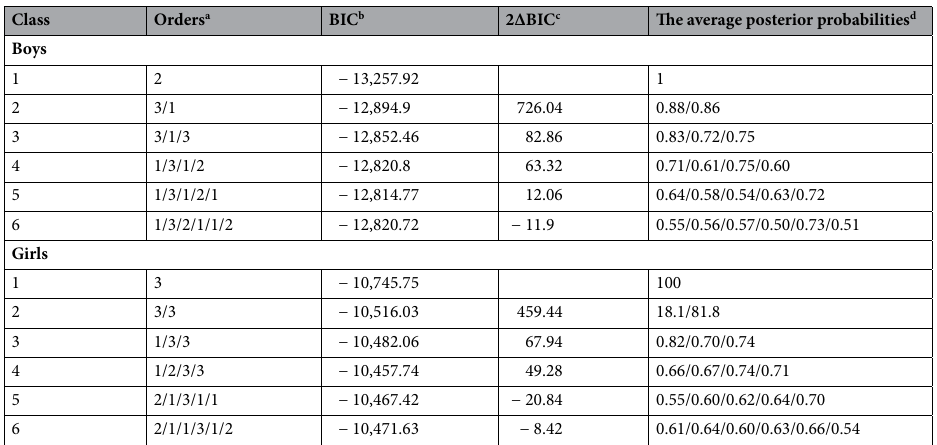
Table 1. Fit statistics for the trajectory classes estimated in the CFPS. a The best polynomial in each class is presented. b BIC = Bayesian information criterion, smaller is better. c Comparision between groups; Interpretation of 2ΔBIC = estimate of 2loge (B 10 ). Evidence against simpler model: 0–2 = not worth mentioning; 2–6 = Positive; 6–10 = Strong; > 10 = Very strong. d Posterior probability values greater than 0.70 indicate that the trajectory includes subjects with similar patterns of